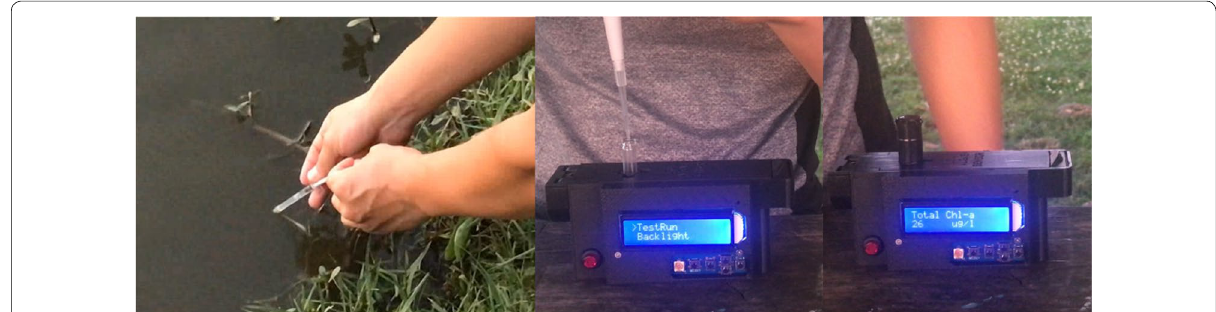
Fig. 5 In‑situ measurement of chlorophyll a and phycocyanin at a local lake using the developed handheld fluorometer